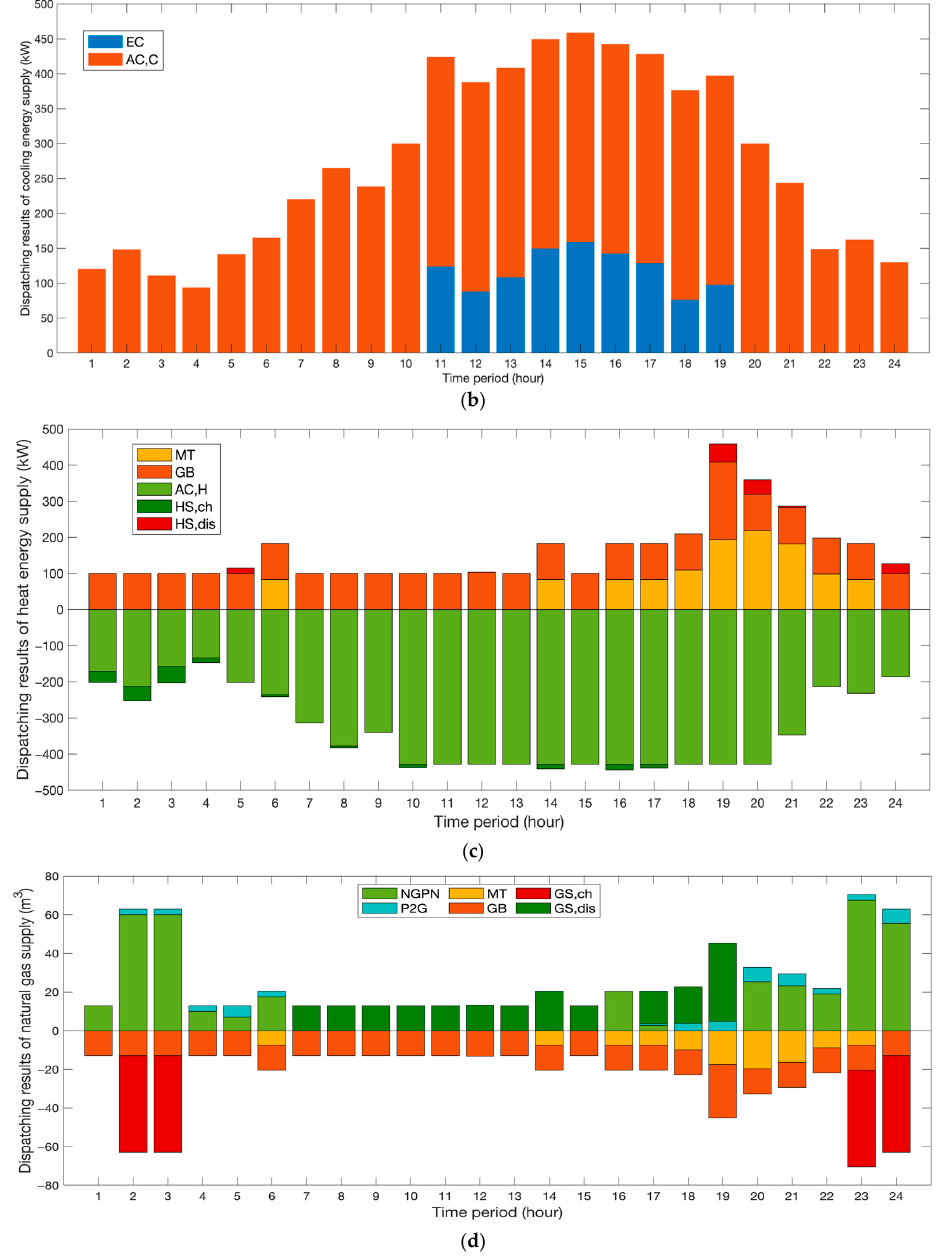
Figure 6. Optimal operation results of Case 1. ( a ) Electrical power optimal scheduling results; ( b ) Cooling energy optimal scheduling results; ( c ) Heat energy optimal scheduling results; ( d ) Natural gas optimal scheduling results.